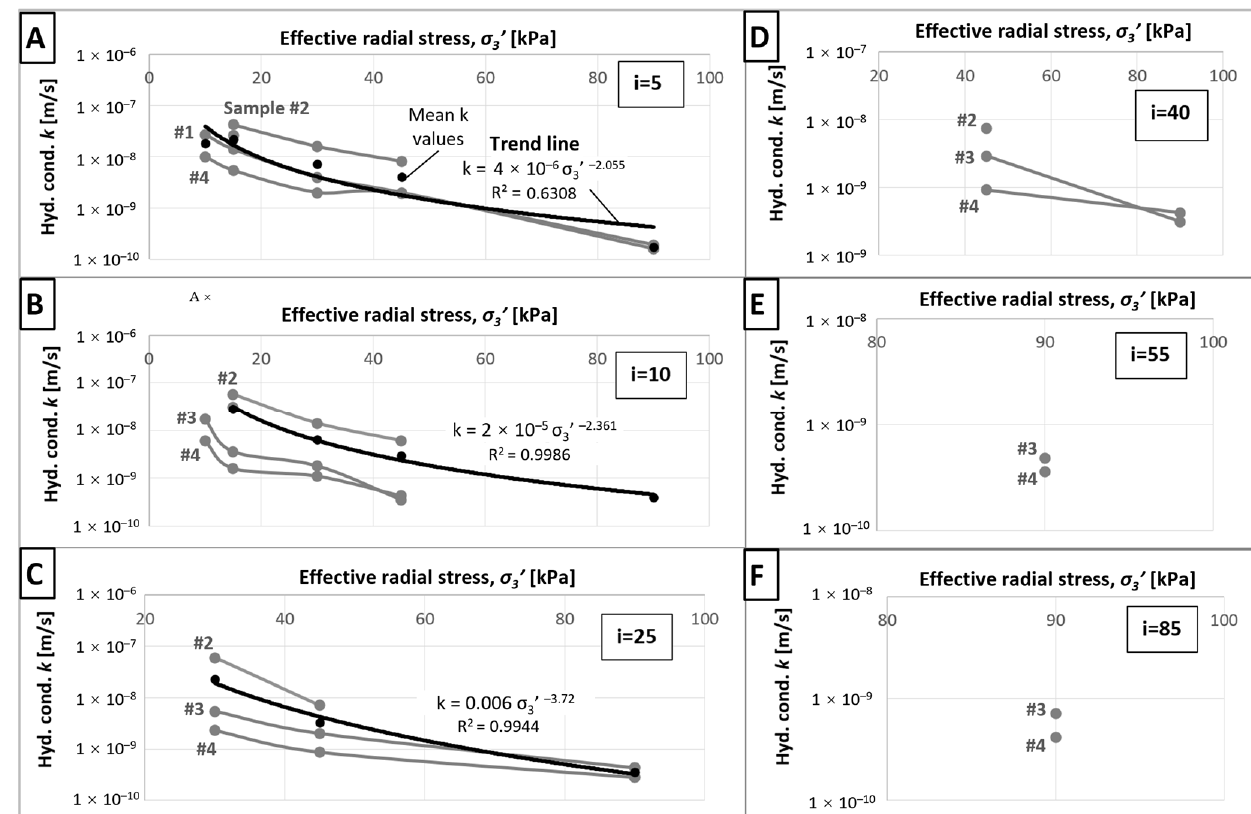
conductivity of 2.5 orders of magnitude between the exemplary warmer surface peat zone (and at lower stress states) and the colder, deeper zones (under higher stress states).